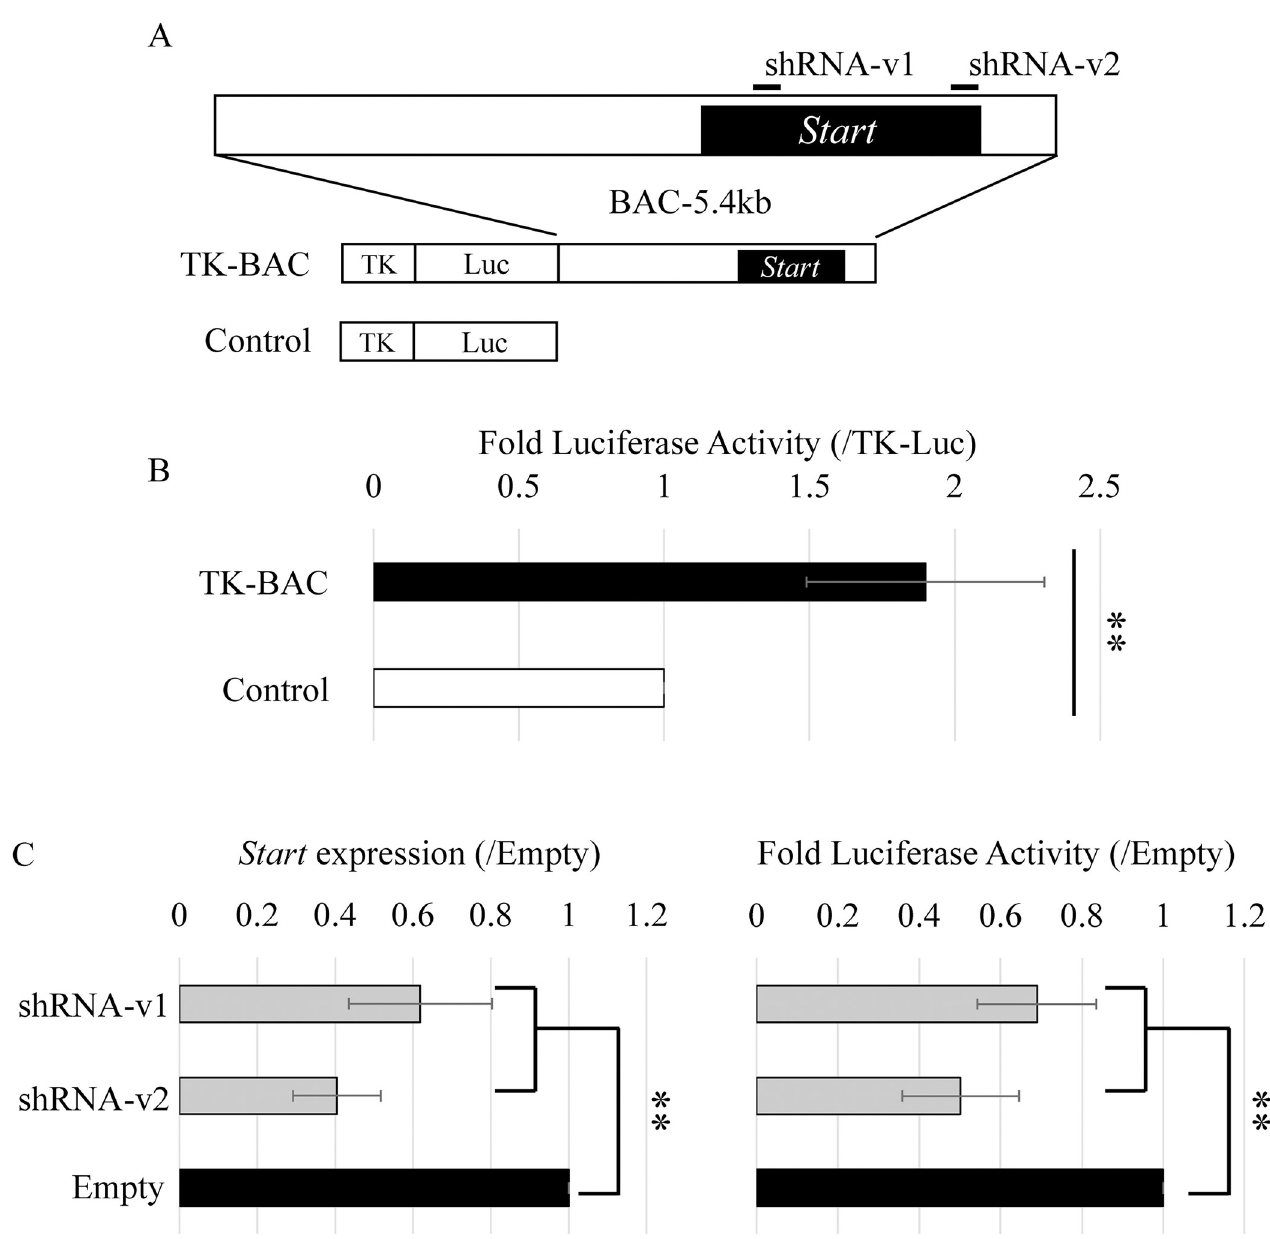
Fig 2. Effects of knockdown (KD) on enhancer activity of the BAC-5.4kb genome sequence encompassing Start . (A) Reporter constructs and positions of sequences targeted by shRNAs. The BAC-5.4kb sequence shown at the top is derived from a BAC clone and carries the full length of Start (a black box). Two short lines represent sequences targeted by shRNAs for the knockdown (KD) experiment in (C). The “Control” vector contains the firefly luciferase gene (Luc) driven by the TK promoter. The “TK-BAC” construct has the BAC-5.4kb sequence downstream of Luc of the “Control” vector. (B) Enhancer activity of the BAC-5.4kb by a reporter gene assay. The “TK-BAC” and “Control” vectors were transfected into GC-2spd(ts) cells, and two days later, the cells were collected, and firefly luciferase activity was measured. Each value was normalized to that of Renilla luciferase activity, which was derived from a co-transfected construct. Data are presented as means ± S.D. from six independent experiments. Statistical significance was analyzed by Student’s t-test. �� P < 0.01. (C) KD of Start decreased enhancer activity of TK-BAC-5.4kb. (Left) KD efficiency of two shRNAs (shRNA-v1 and shRNA-v2) was evaluated by qRT-PCR. The “TK-BAC” construct was stably transfected into GC-2spd(ts) cells, and two shRNA constructs and a control construct (Empty) were transiently transfected into these stable cell lines. After selection with hygromycin, total RNA was collected from each sample and used for qRT-PCR. The Gapdh gene was used as an internal control to normalize the expression level of each gene. (Right) The effect of Start -KD on enhancer activity of BAC-5.4kb was evaluated by a reporter gene assay. Firefly luciferase activity was measured and normalized to the amount of protein determined by the BCA assay. In both graphs, the value in the “Empty” group was set to 1.0. Data are presented as means ± S.D. from five independent experiments. Statistical significance was analyzed by one-way ANOVA followed by Dunnett’s test. �� P < 0.01.